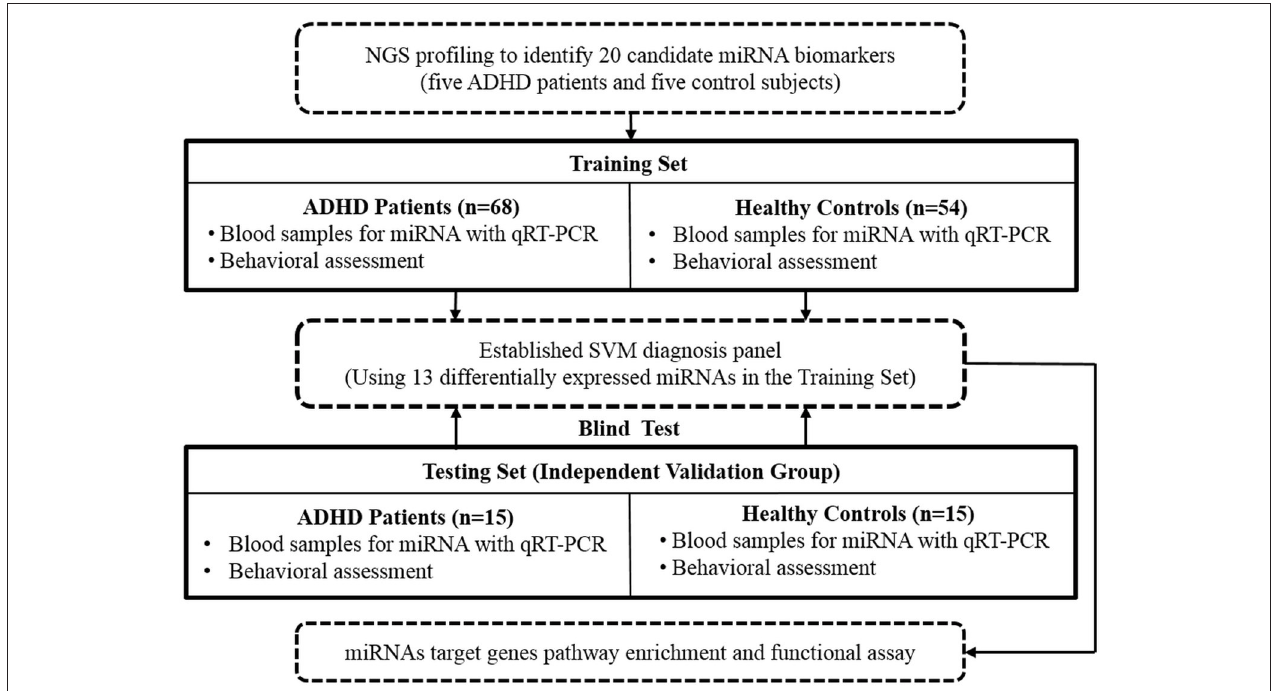
FIGURE 1 | Flow chart of our study design and procedure. NGS, next-generation sequencing; qRT-PCR, real-time quantitative reverse transcription polymerase chain reaction; SVM, support vector machine.